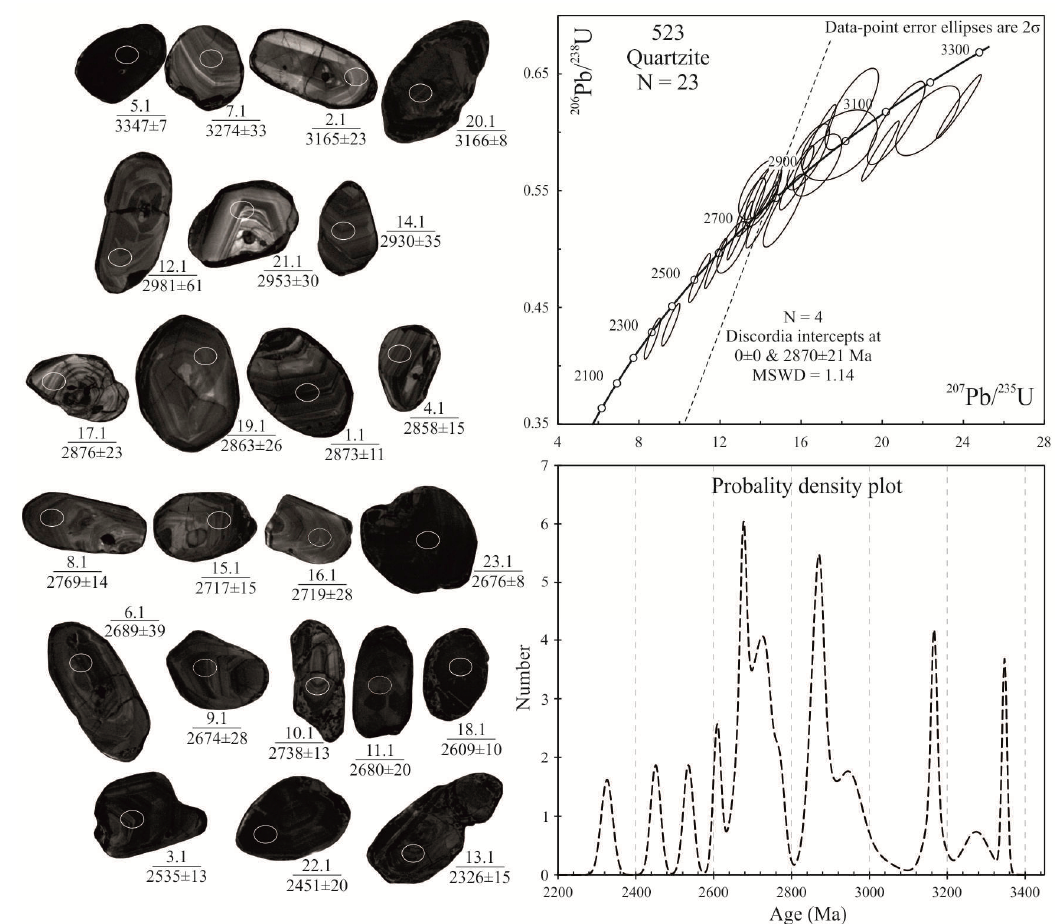
Figure 9. CL images and age of zircons from the quartzite, sample 523.